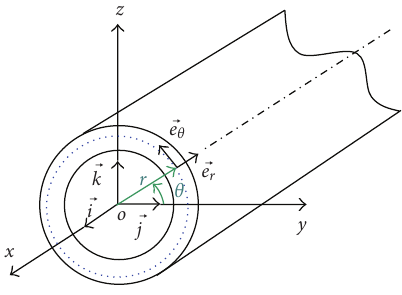
Figure 1: The cylindrical coordinate